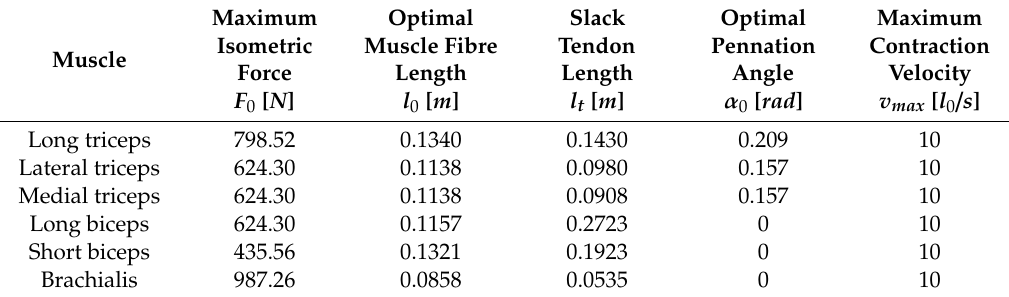
Table 5. Muscles’ properties.